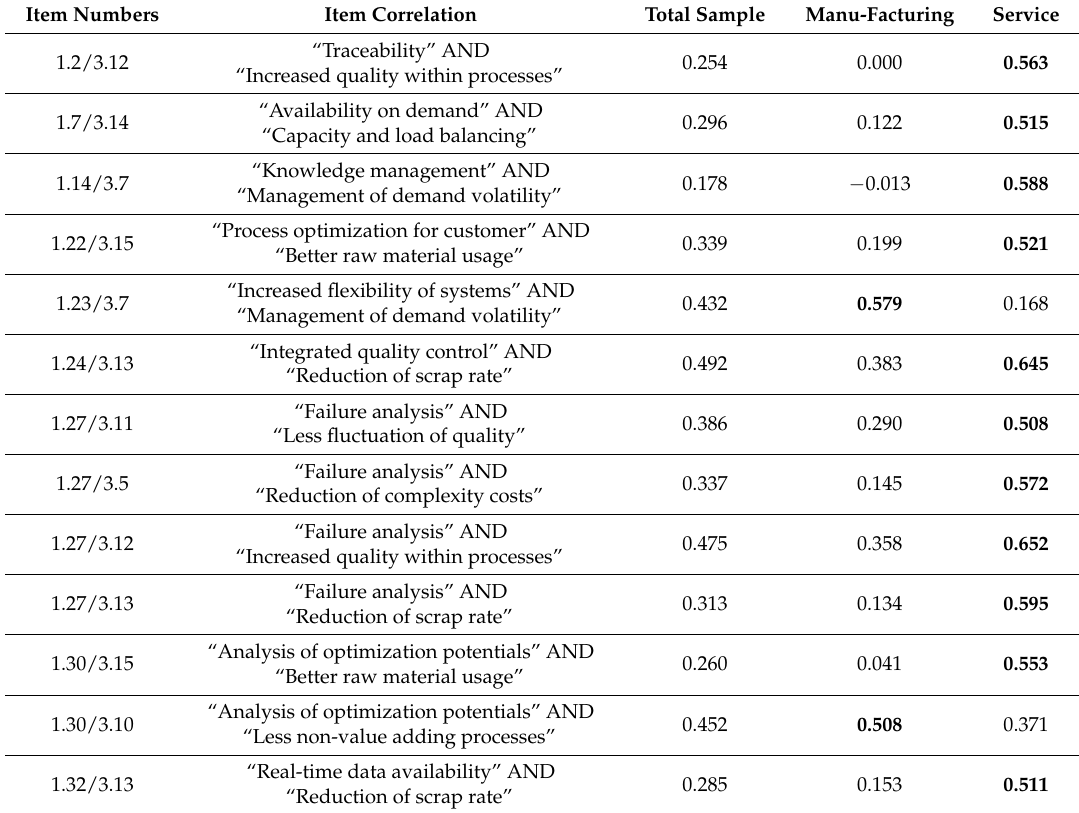
Table 3. Correlations between new business model features and potentials for the